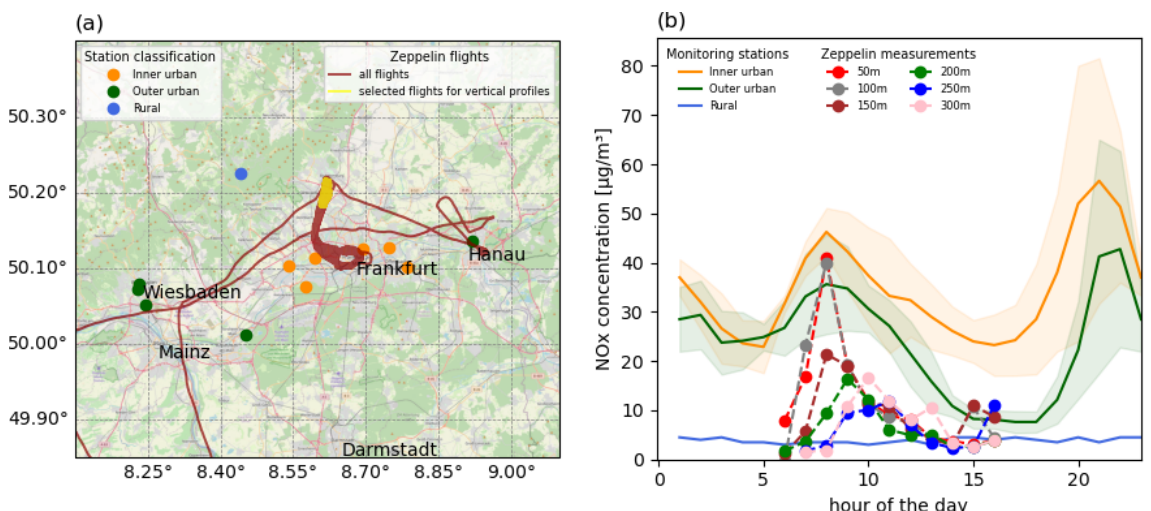
Figure 4. (a) Map of Frankfurt overlaid with the Zeppelin flight tracks in red and yellow that are used to generate the vertical profiles shown on the right. Multiple flight paths to the city center of Frankfurt are overlaid and appear as a thick red line. Also shown are the urban, suburban, and remote monitoring station locations with brown, green, and blue circle markers, respectively (Data provided by the Umweltbundesamt) (© OpenStreetMap contributors 2021. Distributed under the Open Data Commons Open Database License (ODbL) v1.0.). (b) Average diurnal NO x concentration profiles for the urban, suburban, and remote monitoring stations and the Zeppelin diurnal profiles at different